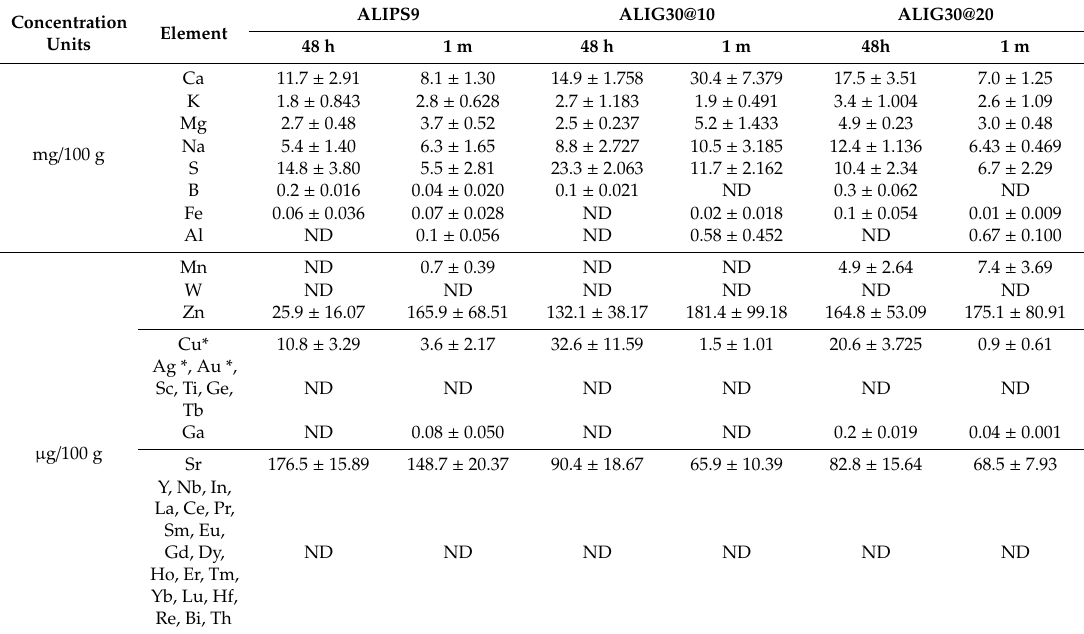
Table 2. Mobility of elements after Franz di ff usion cell tests. Major elements are expressed in mg / 100 g of hydrogel, while the rest of the elements are expressed as µ g / 100 g of hydrogel. Mean values ± s.e. ( n = 6). “ND” stands for “Not Detected”. Release levels of elements marked with * were obtained from